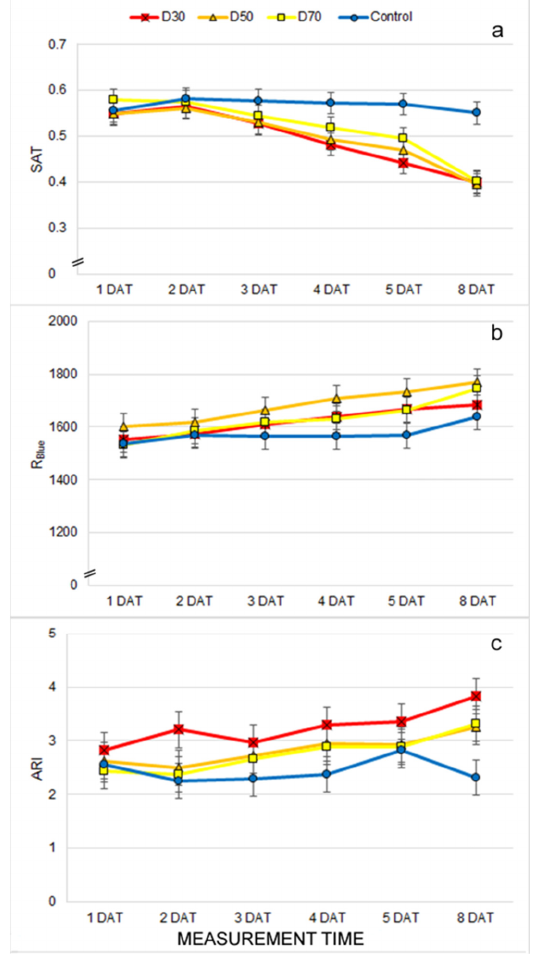
Figure 2. Mean ± double standard error (S.E.) for multispectral traits: ( a ) saturation (SAT), ( b ) reflectance in blue (R Blue ), and ( c ) anthocyanin index (ARI) for plants grown under control and drought treatments (D30, D50, and D70) measured from the first to the eighth day after the beginning of treatments (1 DAT–8 DAT).